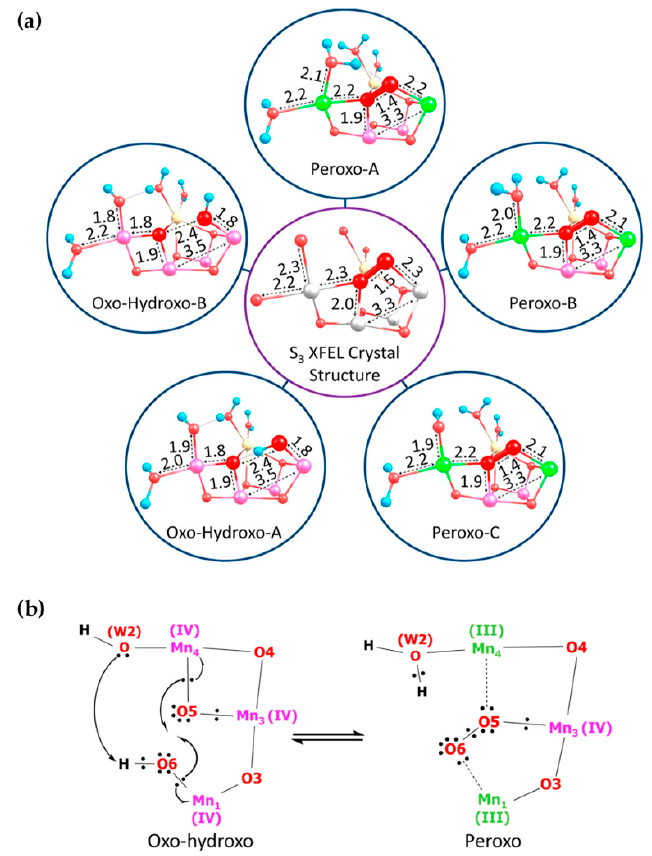
Figure 8. ( a ) Oxo–hydroxo and peroxo models for the S 3 state of the OEC reported by Corry and O’Malley [50]. The XFEL crystal structure of Suga et al. [46] is depicted in the middle. In the optimized structures Mn(IV) ions are shown in pink, Mn(III) in green. ( b ) Scheme showing the electron